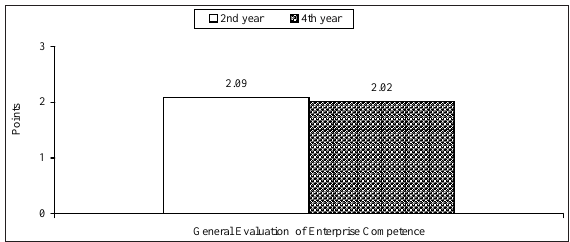
Fig. 7. General evaluation of enterprise